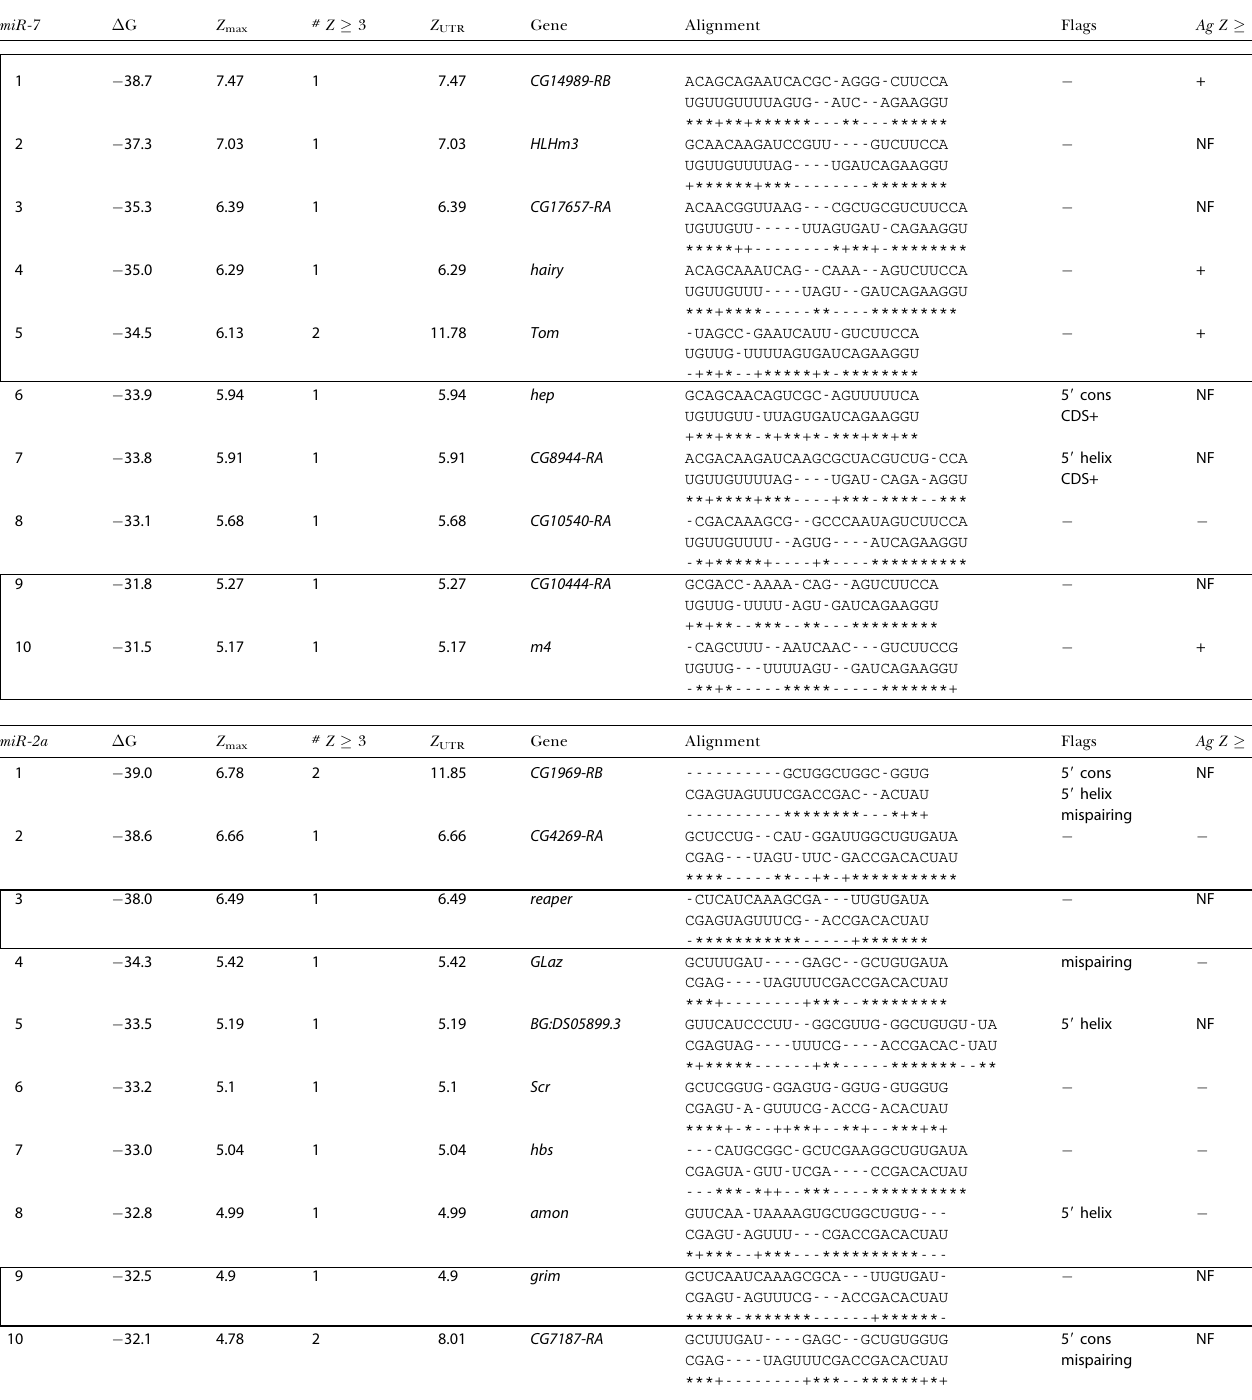
Table 2. Top Ten Predictions for miR-7 and miR-2a